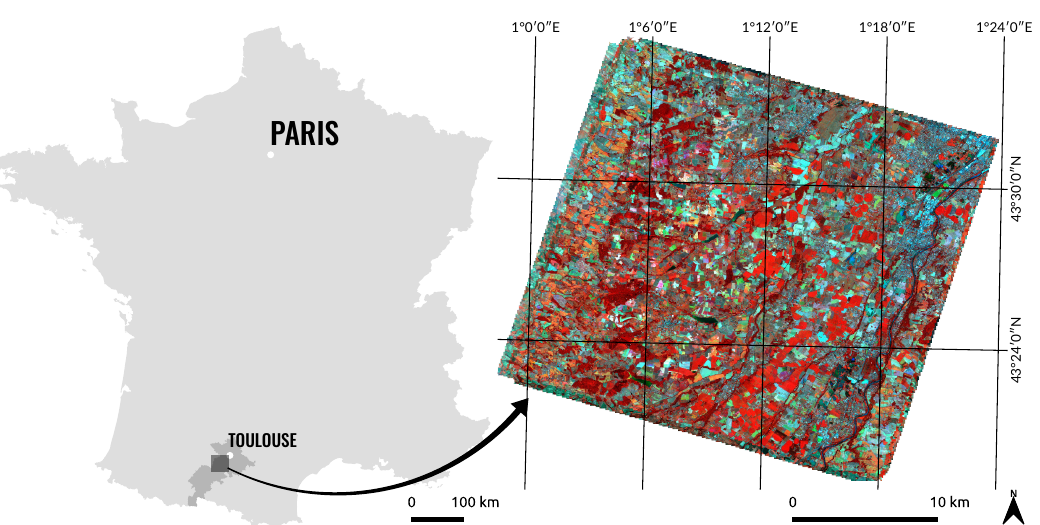
Figure 1. The map on the left shows the location of the study area in the Haute-Garonne district (in dark grey) near Toulouse, France. On the right, a false-color image acquired on 13 August 2013 which represents the entire Formosat-2 scene covering an extent of 24 × 24 km.